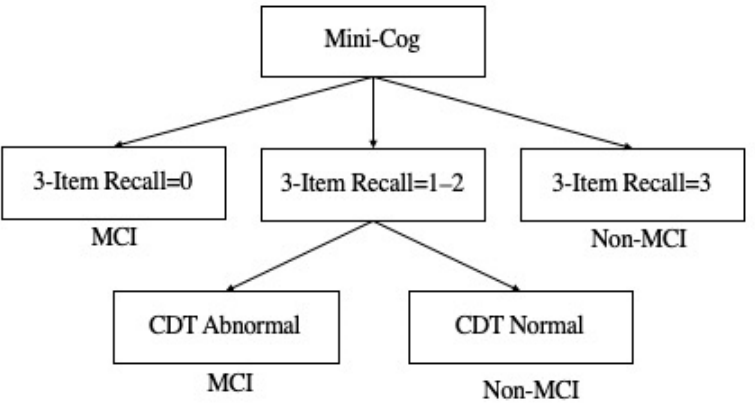
Figure 2. Mini-Cog scoring algorithm.